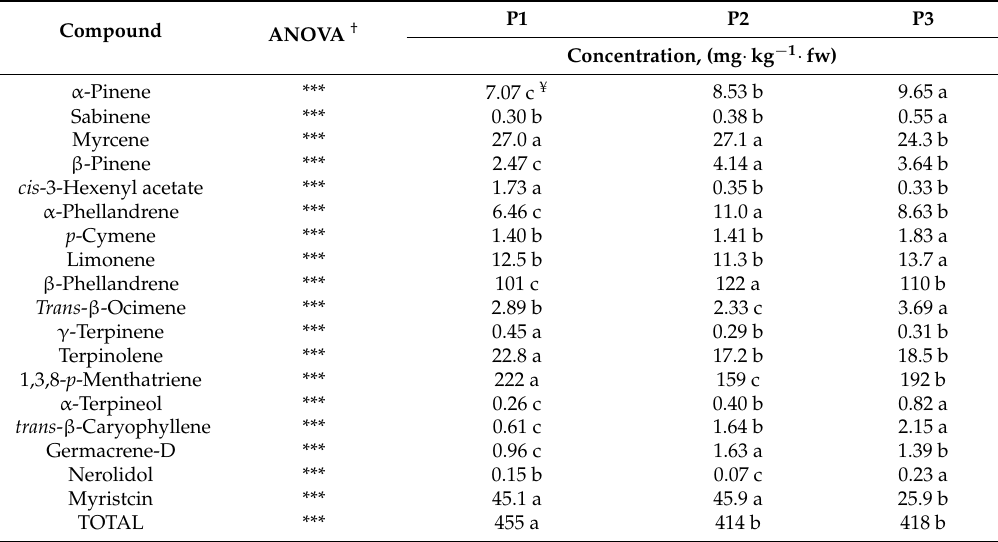
Table 3. Volatile composition of parsley essential oil at three commercial stages (mg ¨ kg ´ 1 ¨